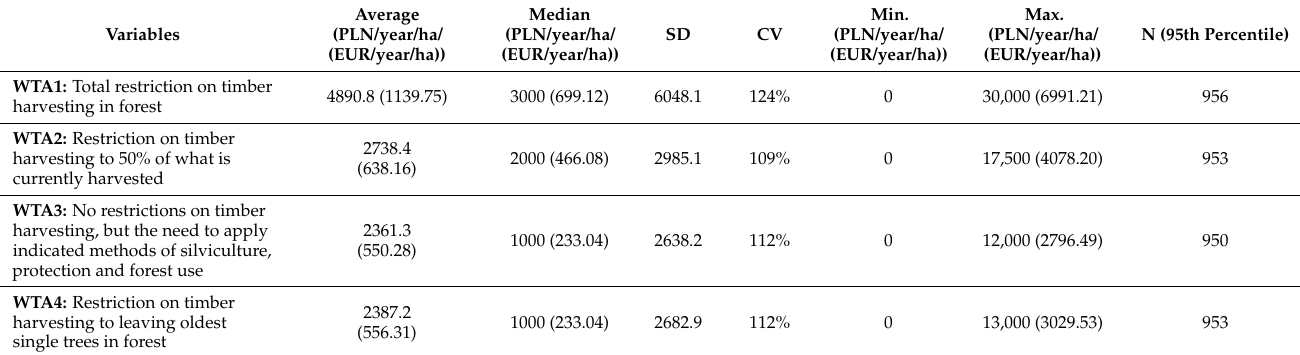
Table 3. Descriptive statistics of WTA variables in analysed models in survey research conducted in April 2019 on random representative nationwide sample of forest owners (farmers). SD, standard deviation; CV, coefficient of variation.